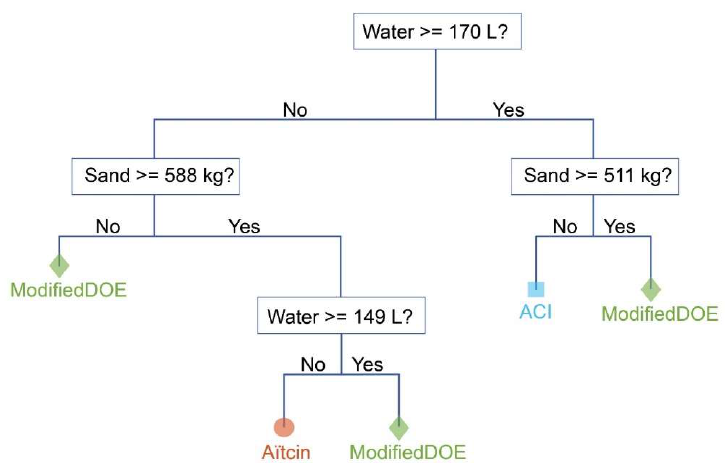
Figure 6. The trained coarse tree classifier; this simple model achieved a testing accuracy of 88.3%.